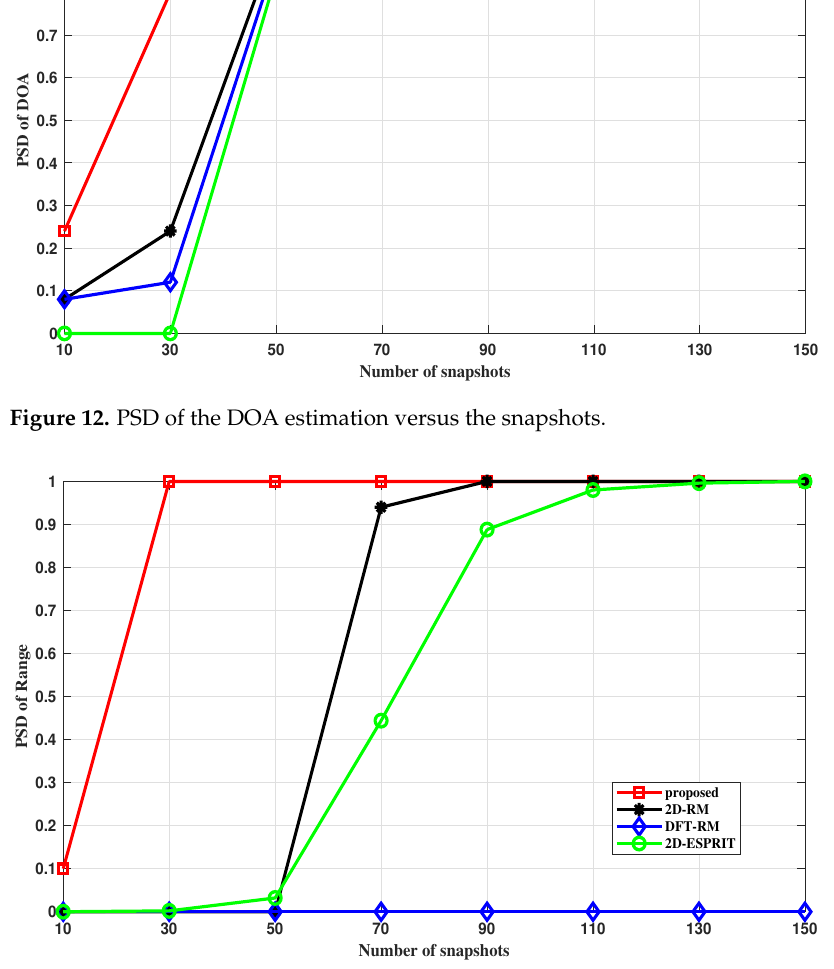
Figure 13. PSD of the range estimation versus the